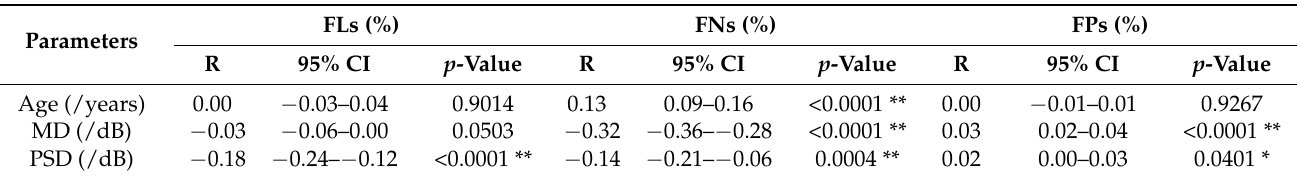
Table 6. Possible association between each reliability index and various parameters in 40-year-old or older subjects by multivariate